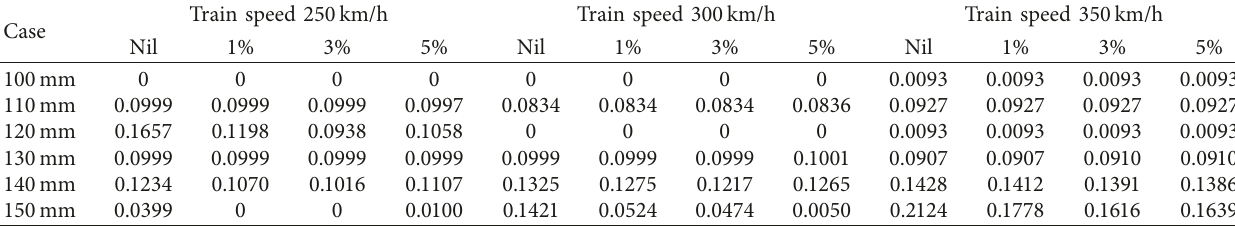
Table 4: Wavelength estimation error at different train speeds.